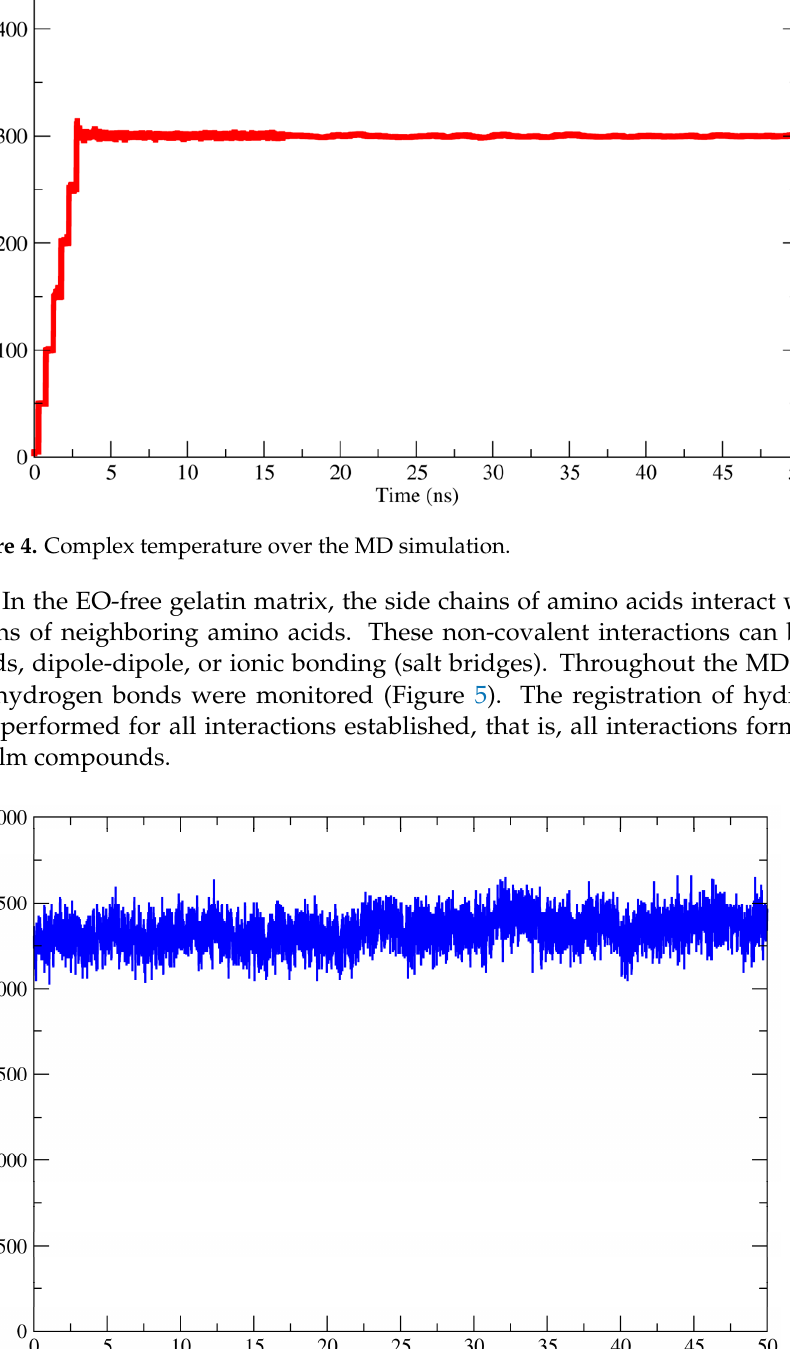
Figure 3. Complex minimization energy.